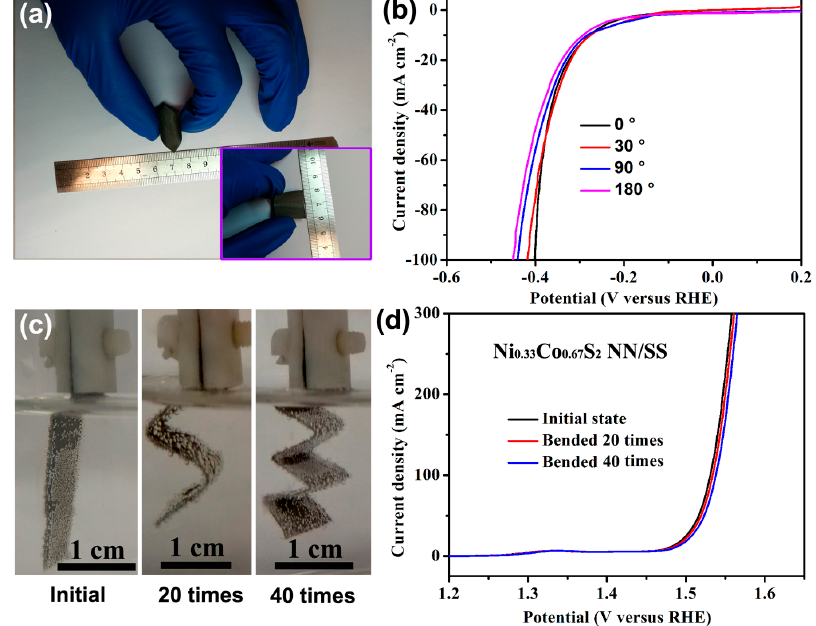
Figure 7. ( a ) Photograph of the flexible Ni 0.33 Co 0.67 S 2 NN/SS electrode at bended states. The inset shows the normal state; ( b ) HER polarization curves of Ni 0.33 Co 0.67 S 2 NN/SS electrodes at different bending angles; ( c ) Oxygen evolution images of Ni 0.33 Co 0.67 S 2 NN/SS electrodes at the initial state and after bending 20 and 40 times with an OER current density of 300 mA cm − 2 ; ( d ) OER polarization curves of Ni 0.33 Co 0.67 S 2 NN/SS electrodes after different bending times.